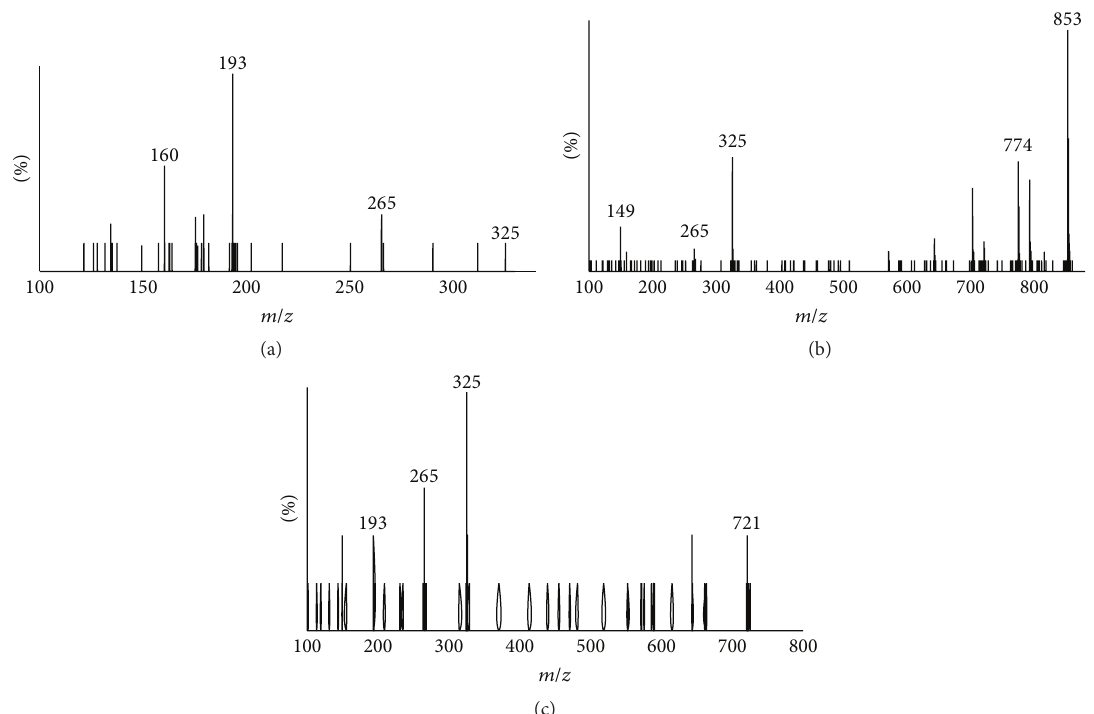
Figure 3: MSMS spectra of feruloyl mono- and oligosaccharide arabinoxylans [M-H] − from corn bran and wheat aleurone: (a) 𝑚/𝑧 = 325; (b) 𝑚/𝑧 = 853; and (c) 𝑚/𝑧 = 721.